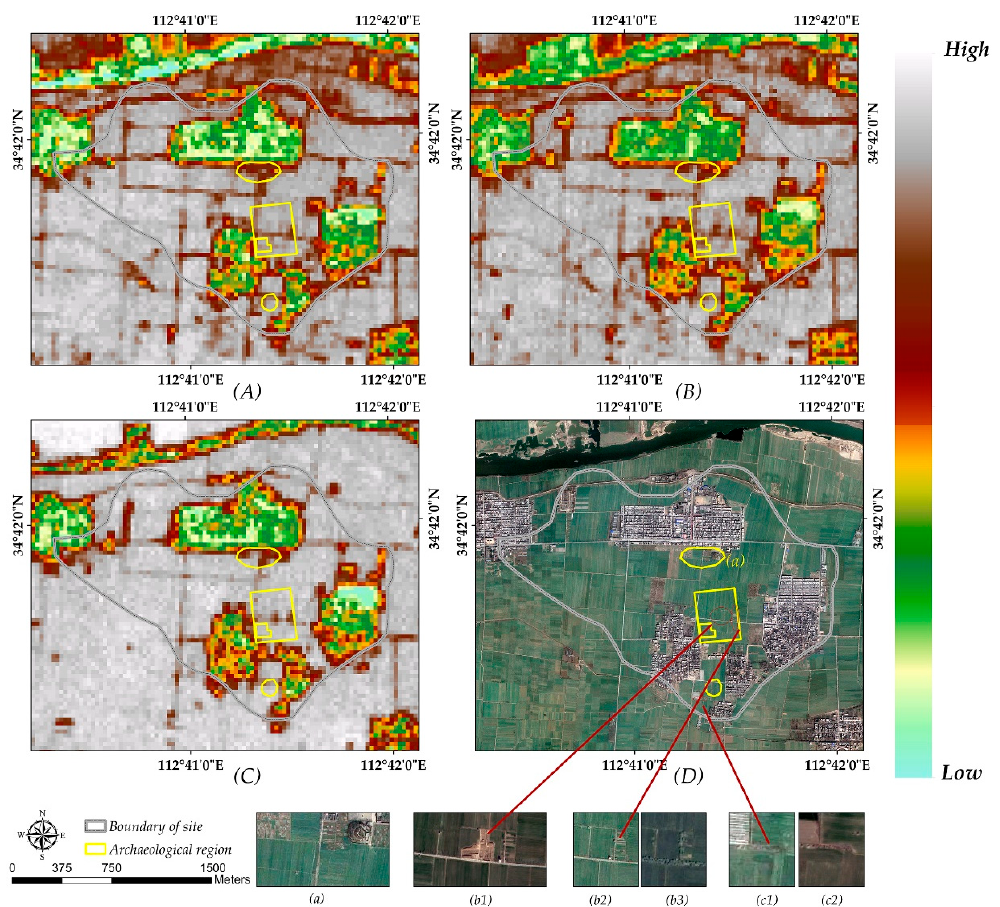
Figure 9. The distribution of negative crop anomalies and the main archeological features of Erlitou. ( A ) Landsat NDVI of 6 May 2000; ( B ) Landsat NDVI of 10 May 2001; ( C ) Landsat NDVI of 21 August 2001. ( D ) Google Earth image of 19 March 2010: ( a ) sacrifice area and aggregate pit, 1983 partly; ( b1 ) the excavation image of palace bases No. 5 and No. 3 on WorldView-2 image at 30 December 2010; ( b2 ) the eastern wall of the imperial palace, palace bases No. 5 and No. 3, 2003–2010; ( b3 ) the eastern wall of the imperial palace, palace bases No. 5 and No. 3 at images 15 August 2012; ( c1 ) the southern ditch of cast copper relics regions, 1983; ( c2 ) the southern ditch on WorldView-2 image of 30 December 2010. The features have since been refilled following an excavation project.